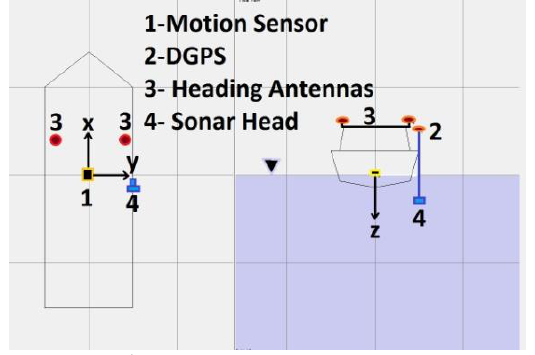
Figure 3: System installation schema.